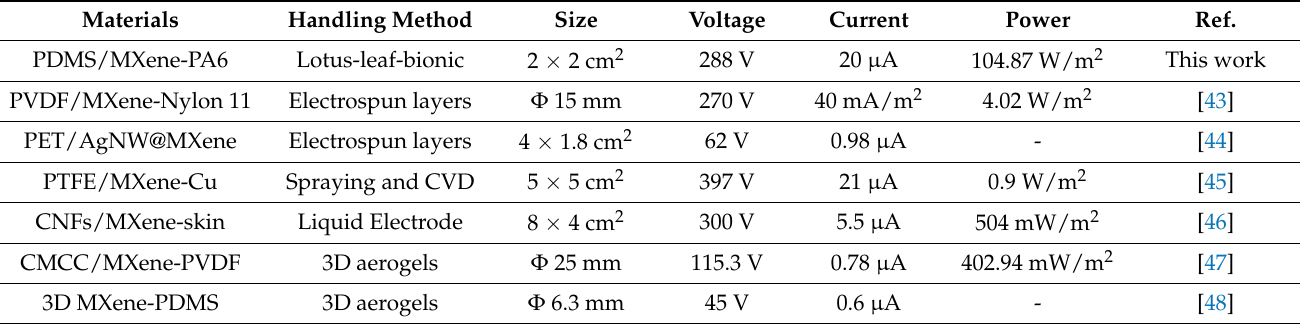
Table 1. Performance comparison of the LLB TENG with other devices using